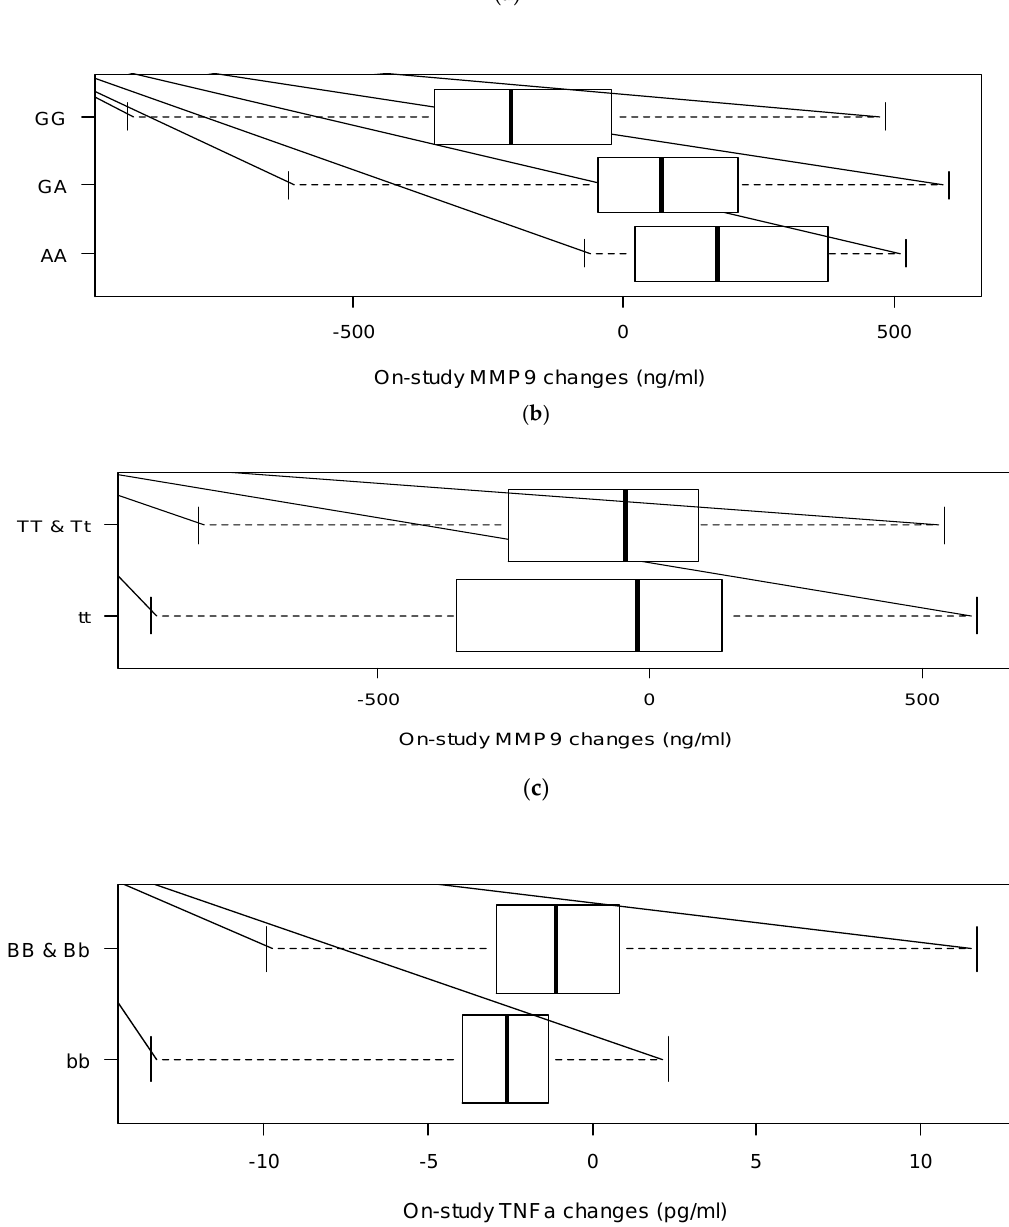
Figure 1. DuringinterventioninflammatorybiomarkerchangesinresponsetovitaminD3supplementation Figure 1. During intervention inflammatory biomarker changes in response to vitamin D3